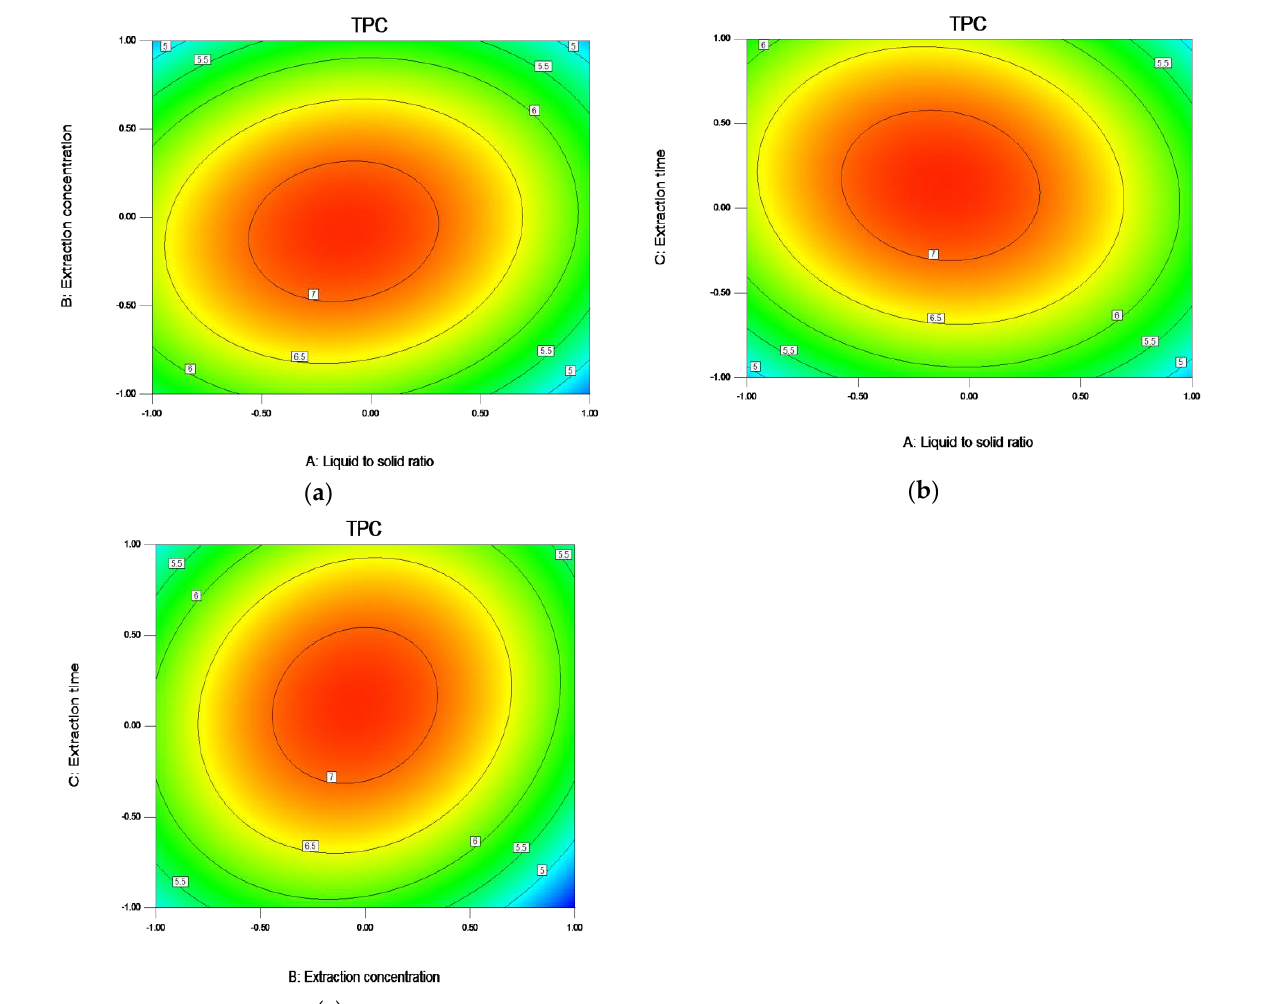
Table 7. Repeat verification experiment results.